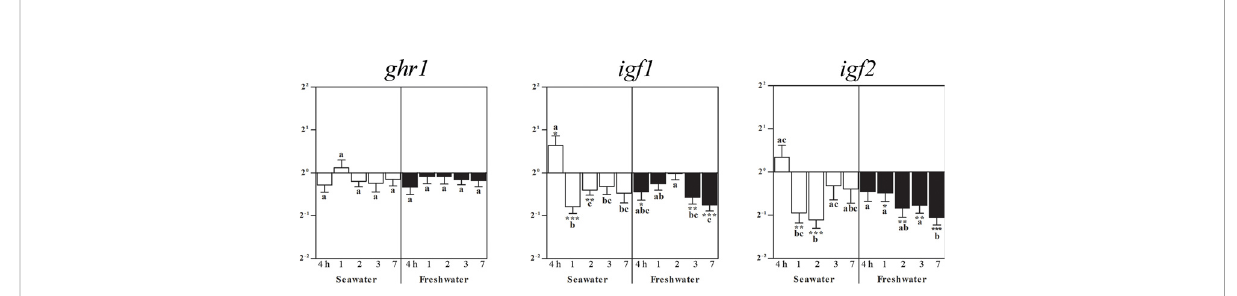
FIGURE 2 Effects of salinity on brain ghr1 , igf1 , and igf2 gene expressions. Relative changes (log 2 , y-axis) of mRNA expression at 4 h, 1, 2, 3 and 7 days (x- axis) after exposure to seawater (white columns) and freshwater (black columns). Bars represent mean ratios between treated and control group ± SEM and asterisks show signi fi cant differences: * p < 0.05; ** p < 0.005; *** p < 0.0005. Bars within treatment groups that do not share any letters are signi fi cantly different from each other with p < 0.05, e.g., igf1 seawater expression between 4 h and 1 day, 2, 3 days and 7 days are signi fi cantly different, but between 1 day or 2 days, and 3 or 7 days are not signi fi cantly